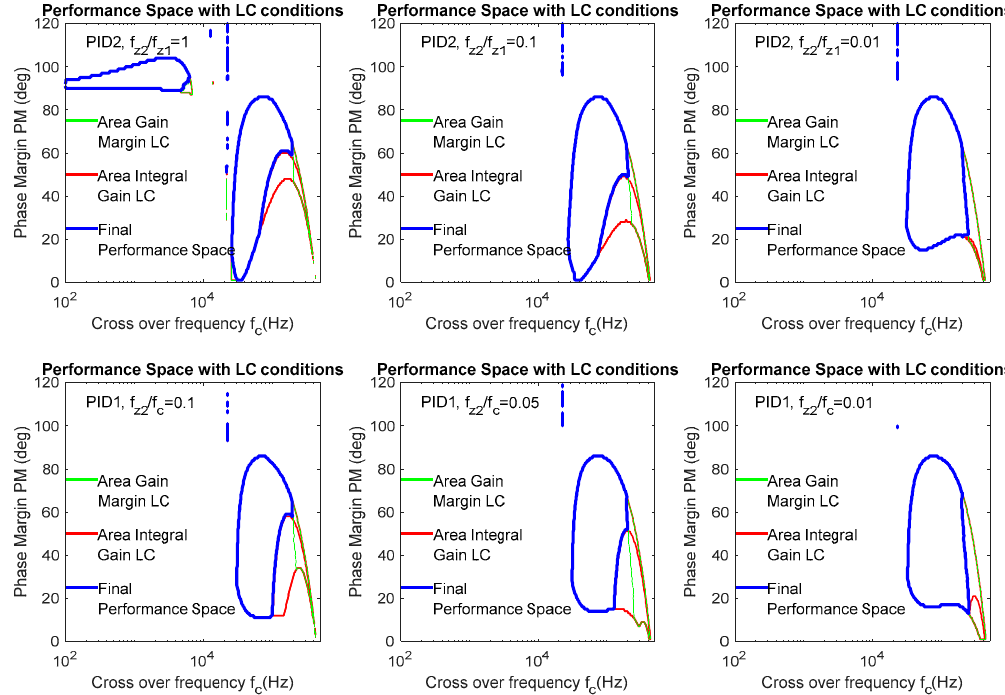
Figure 8. Performance space for PID compensators, remarking areas discarded due to the limit cycling (LC) conditions.